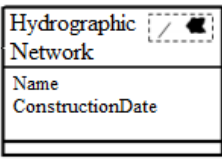
Figure 7. Example of fuzzy complex